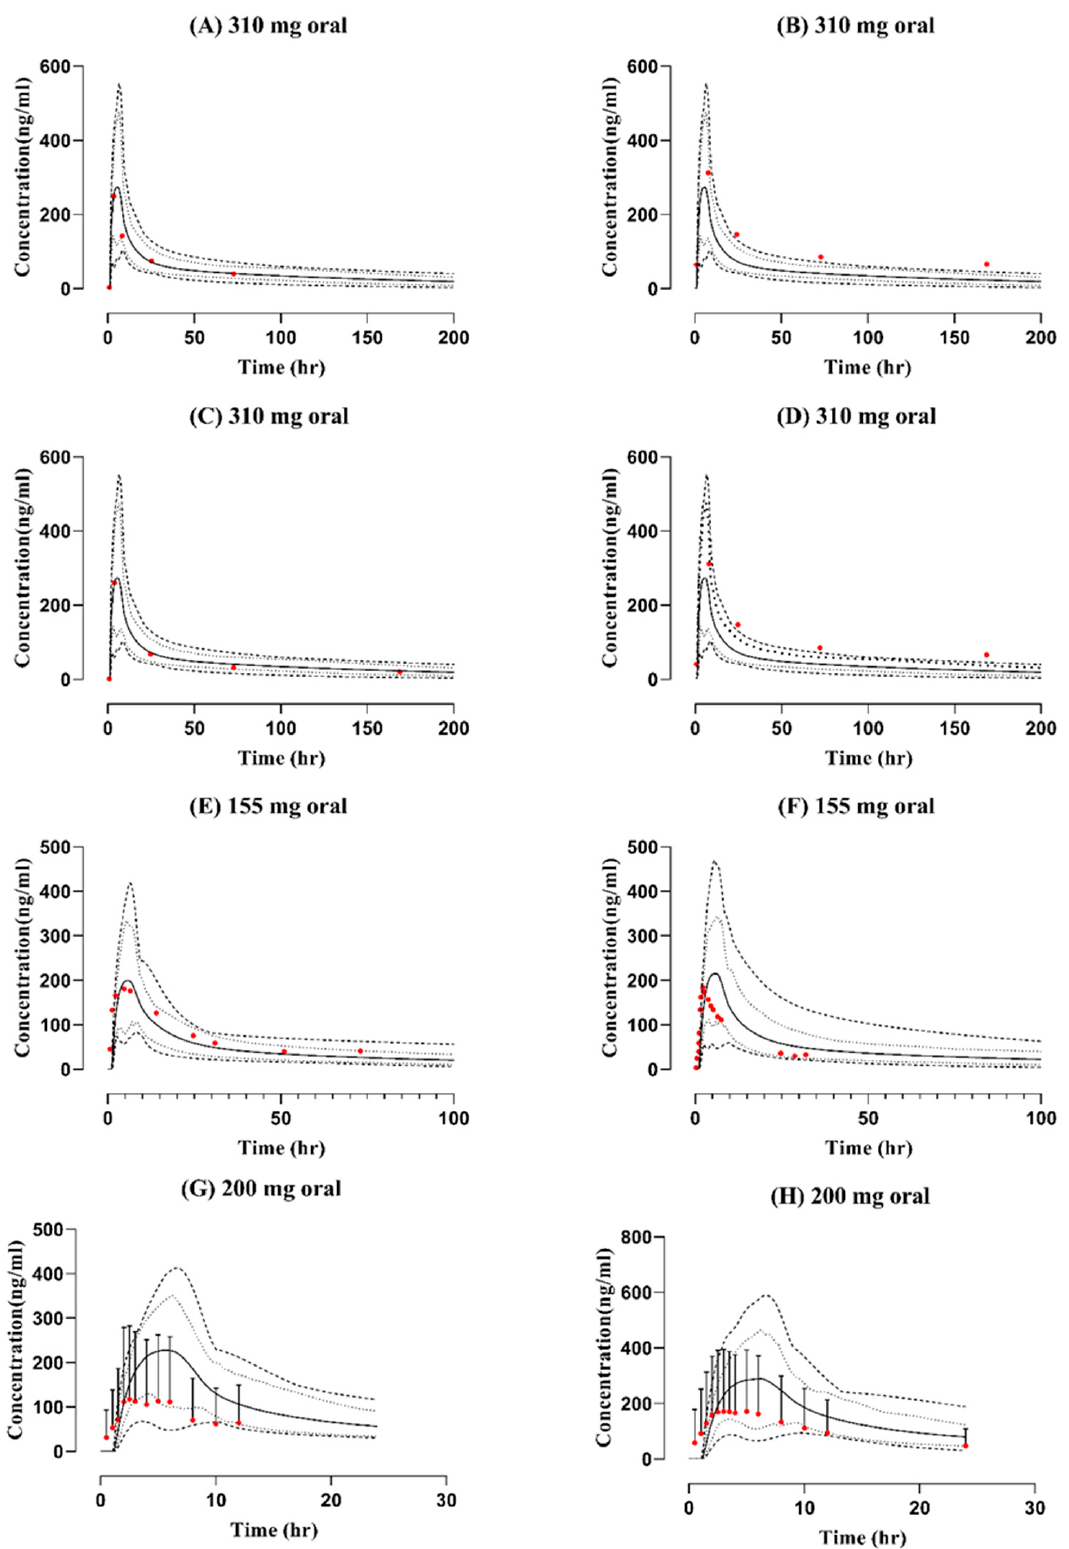
Figure 3. Observed and predicted blood concentration-time profiles comparison after oral admin- istration of dose ( A ) 310 mg [30], ( B ) 310 mg [30], ( C ) 310 mg [30], ( D ) 310 mg [30], ( E ) 155 mg [6], ( F ) 155 mg [29], ( G ) 200 mg [31], ( H ) 200 mg [32]. Solid lines are presented as mean, dashed lines as minimum, maximum and dotted lines as 5th–95th percentile and red-filled circles as observed data. Table 3. Mean R obs /R pre ratios of various pharmacokinetic parameters after intravenous and oral administration of hydroxychloroquine in the healthy population.